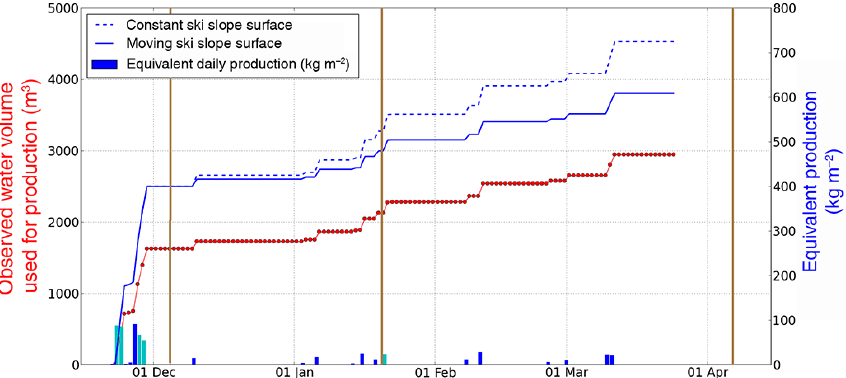
Figure 2. Observed water volumes used for production (red) and the equivalent mass on the ski slope surface (blue). Bars stand for the daily production (bottom). Production sessions when observations were performed on MM snow piles (cyan bars) and dates when ski slope observations were carried out (light brown) are